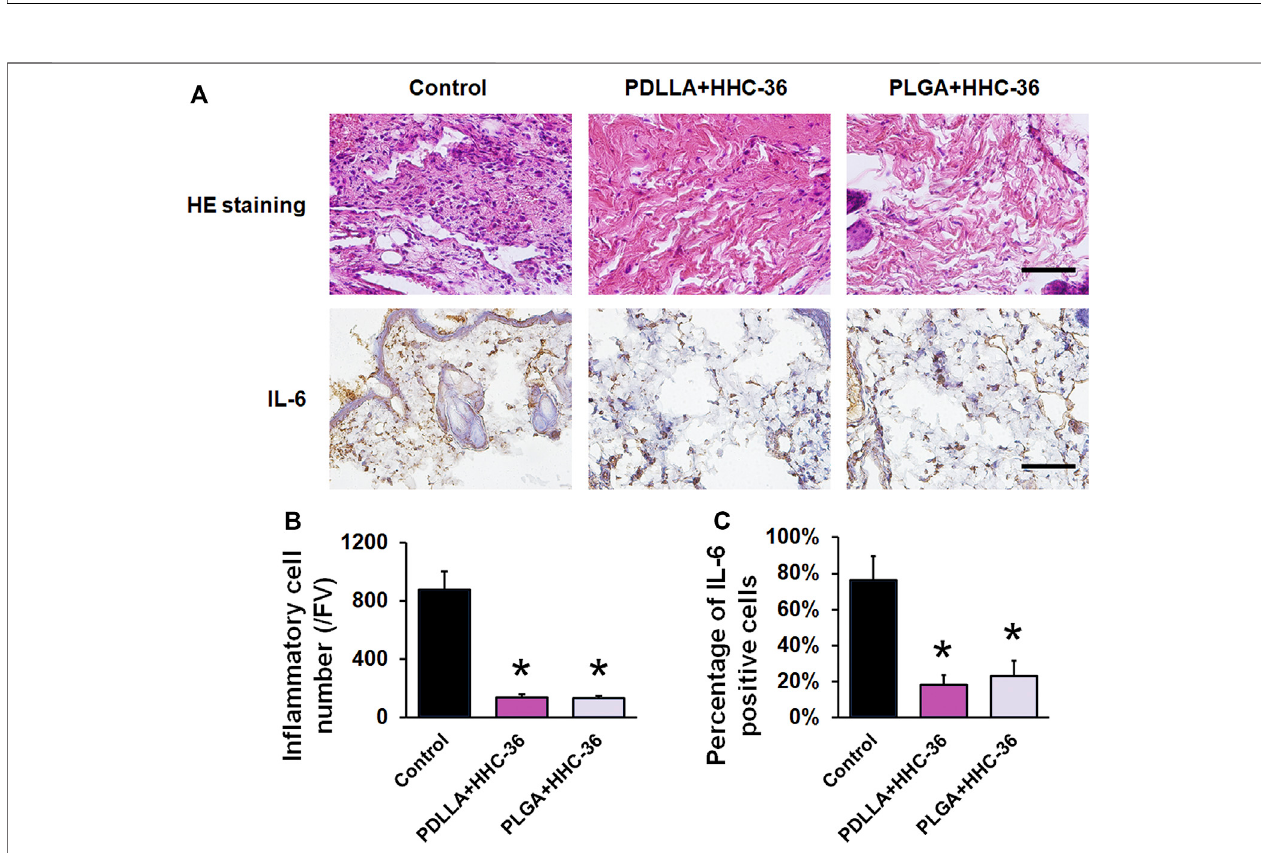
FIGURE5| Evaluationoftheinfectionindicators invivo .( A )H&EstainingandIL-6immunohistochemicalstaining.Bar (cid:1) 200 μ m.( B )In fl ammatorycellnumber/FVof H&E staining. ( C ) Semiquantitative results of IL-6 positive cells. * p < 0.05 vs. the controls.